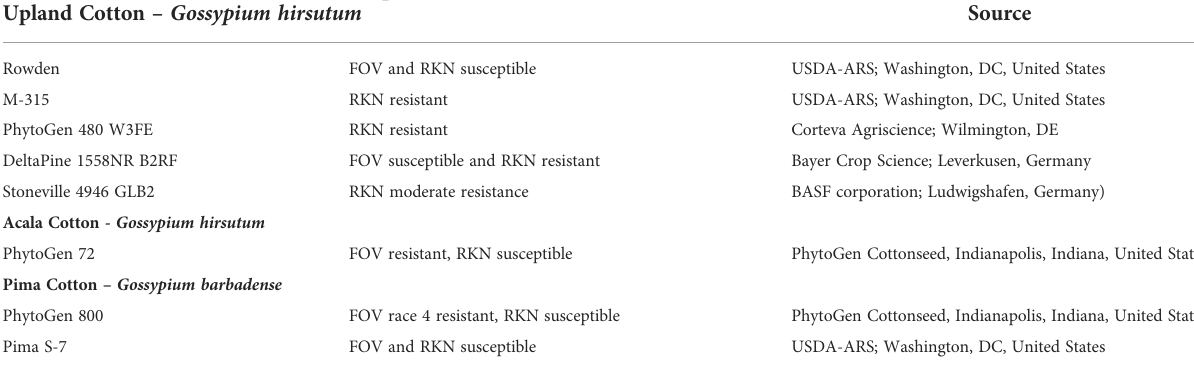
TABLE 1 List of cotton cultivars and their reported resistance traits to either Fusarium oxysporum f. sp. vasinfectum (FOV) or Meloidogyne incognita the root-knot nematode (RKN). Cotton